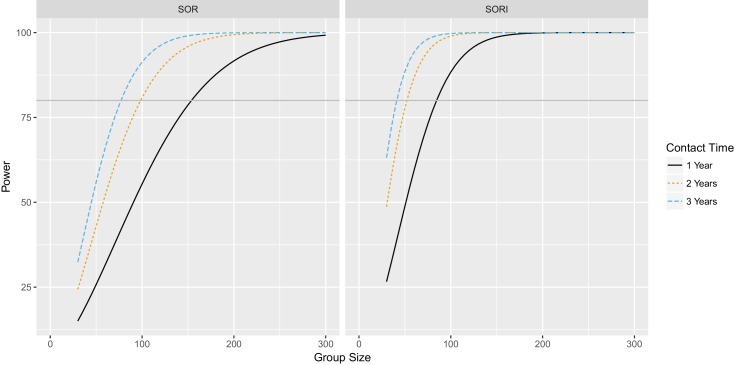
Power to estimate 75% total vaccine efficacy for SOR and SORI parameter estimates for contact times of one, two and three years Statistical power as a function of group size to estimate a significant difference in vaccinated and unvaccinated groups at the 95% level for an effect size of 75% total vaccine efficacy based upon SOR and SORI parameter estimates.Grey line indicates the 80% power level.